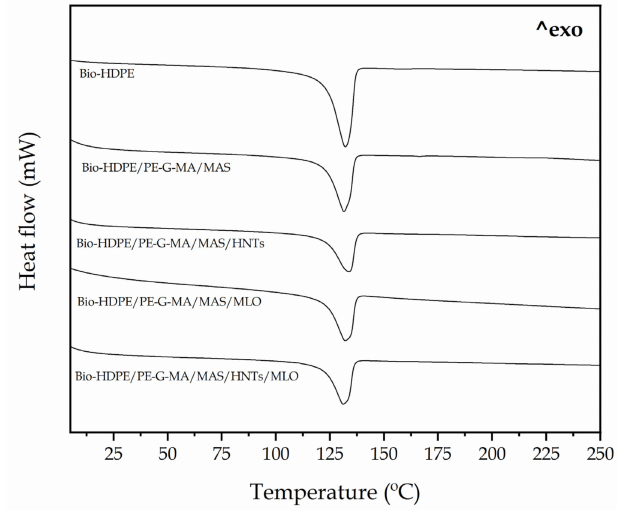
Figure 5. Differential scanning calorimetry (DSC) thermograms of Bio-HDPE/PE-g-MA/MAS blends with different compatibilizers. Table 3. Melting temperature (T m ), melting enthalpy ( ∆ H m ) and crystallinity (X C ) of